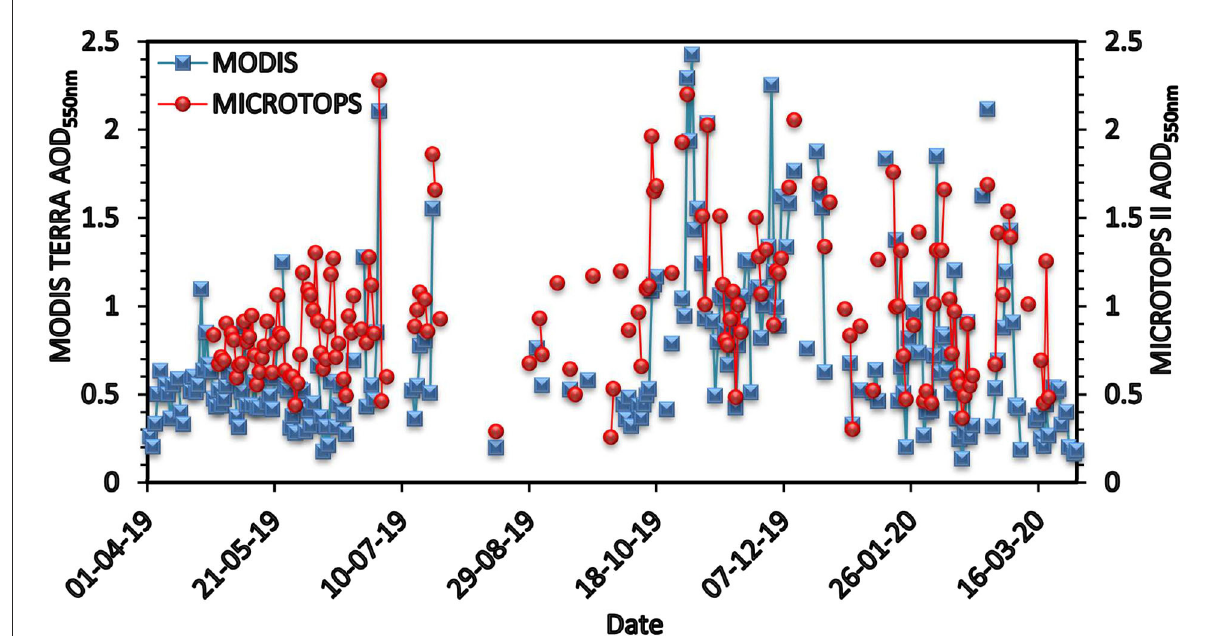
FIGURE9 Comparison of MODIS AOD at 550nm with the MICROTOPS-II at time of pass of Terra satellite over Varanasi during the study period (April 2019–March 2020).